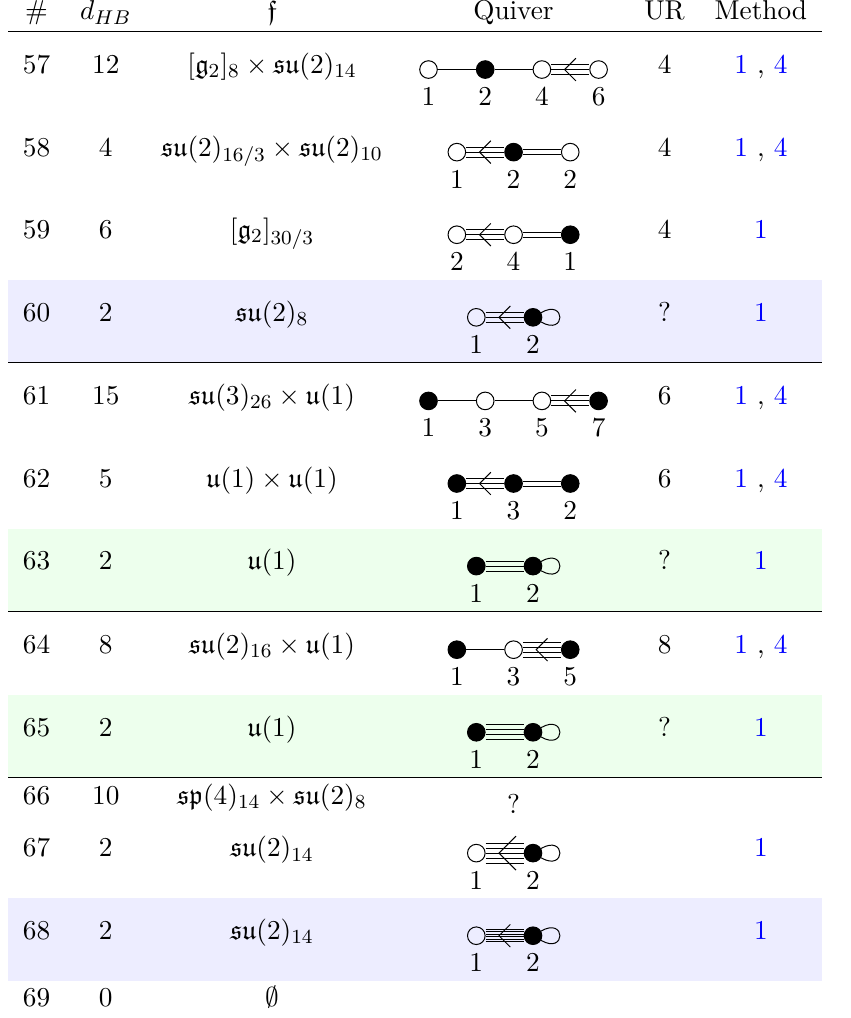
Table 6 . List of magnetic quivers (continued). Lines shaded in blue correspond to 4d theories. Lines shaded in green correspond to 4d